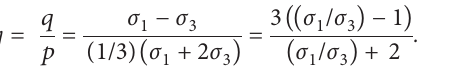
Figure 19: The force analysis of soil particles under axial extension condition. (a) The force analysis of soil particles O of soil particles O 4